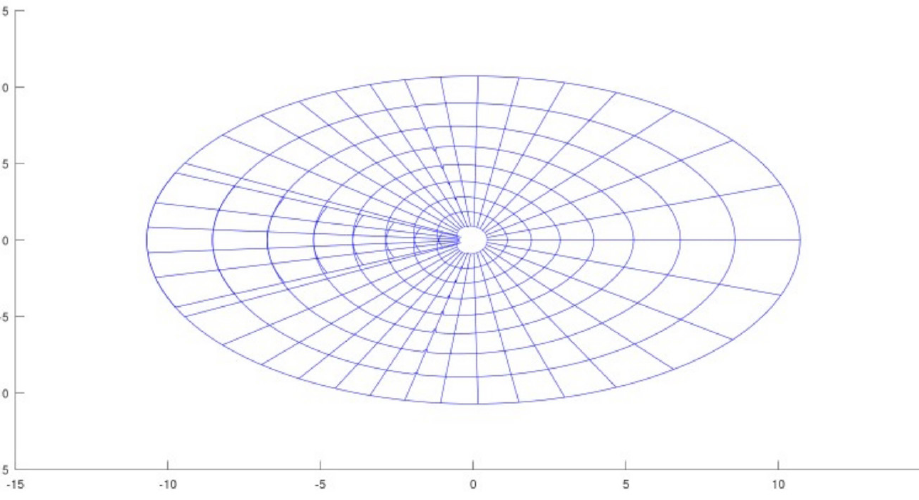
Fig. 10. The cartographic grid in the normal azimuthal projection created based on the isometric